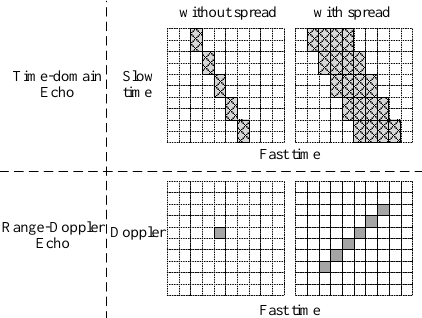
Figure 1. Time-domain echo and range-Doppler plane comparison of non-spread and spread